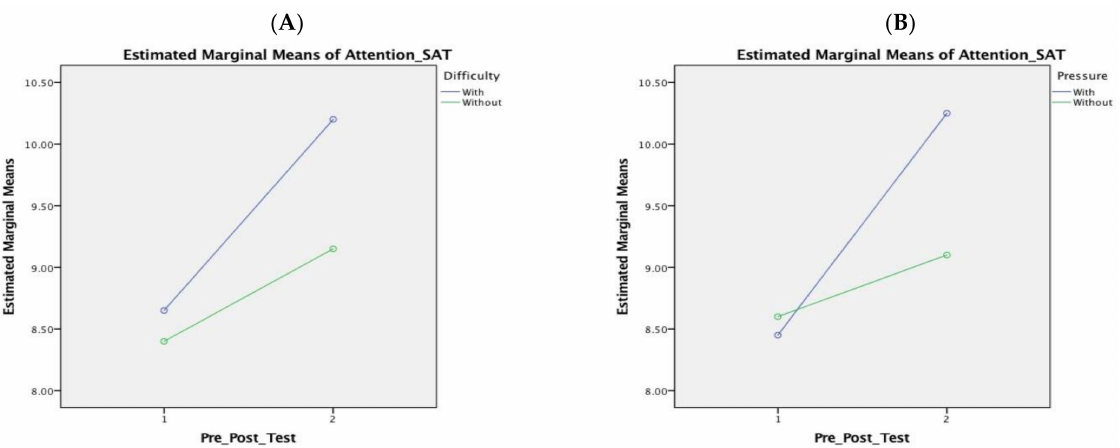
Figure 8. The graph of two-factors interaction in SAT. Figure ( A ) shows the interaction of pre/post- test * difficulty; Figure ( B ) shows the interaction of pre/post-test * pressure. Note: pre/post-test (the horizontal axis), pre-test = 1, and post-test =